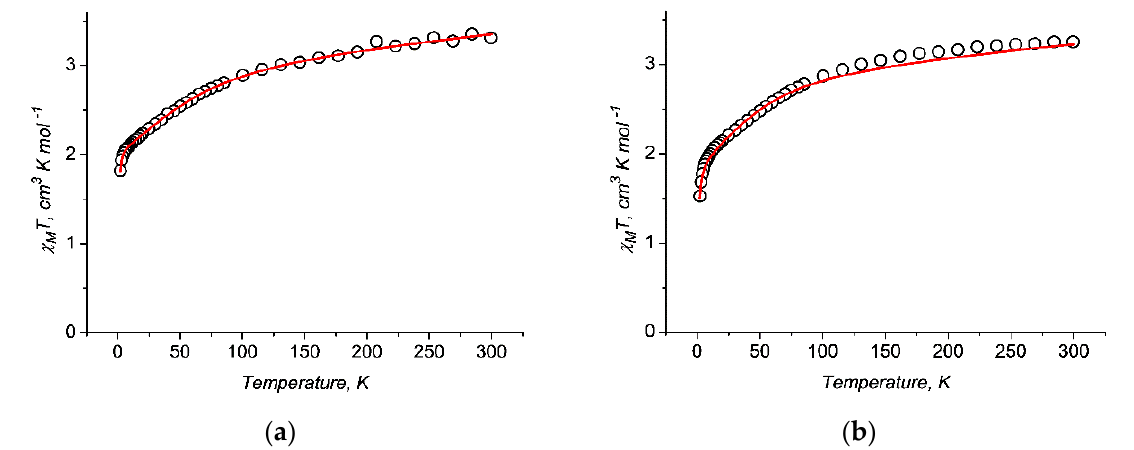
Figure 5. Temperature dependence of χ M T for 1 ( a ) and 2 ( b ) (calculated per one Co atom) measured at H = 5000 Oe. The lines show approximations by the Griffith Hamiltonian equation [31].